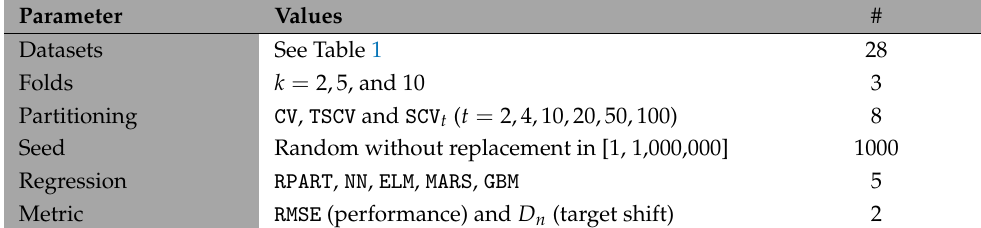
Table 3. Details of the